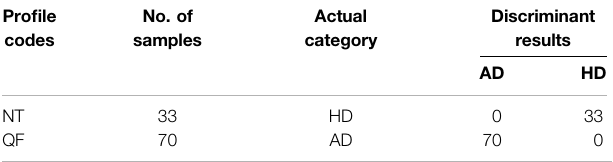
TABLE 6 | The identi fi cation result of the QF pro fi